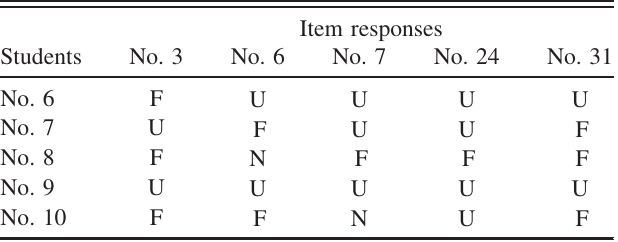
TABLE VII. Effort item responses during the interviews of the students with low favorable precourse effort expectations: favor- able (F), neutral (N), and unfavorable